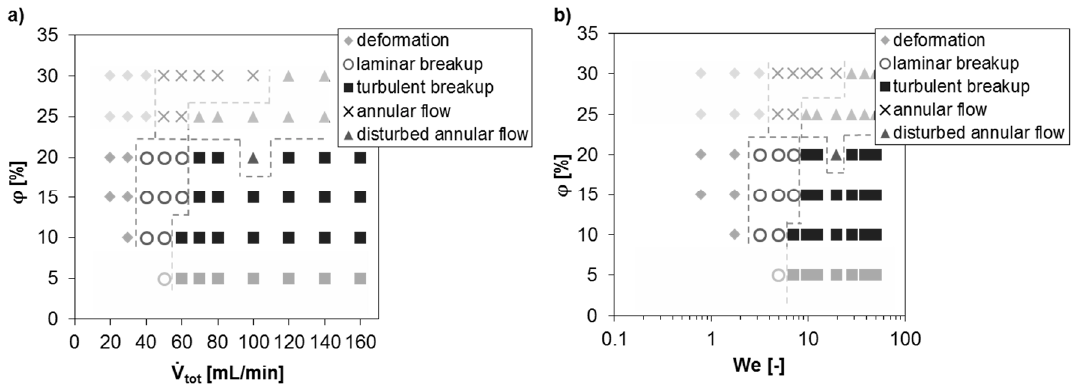
Figure 8. Bubble breakup regime maps using nozzle inlay A. Regions outside of 10% < ϕ < 20% and 20 mL/min < V tot < 160 mL/min are faded due to earlier exclusion. ( a ) Bubble breakup map for void fraction plotted over total volumetric flow rate; ( b ) bubble breakup map for void fraction plotted over characteristic Weber number.